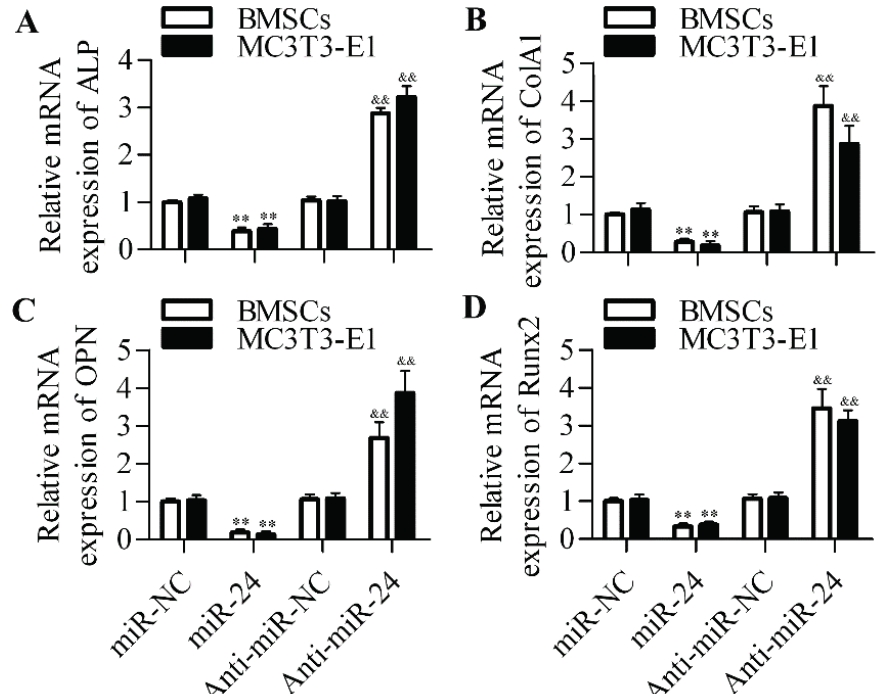
Figure 3. Effect of miR-24 gain or loss on the mRNA expression of osteogenesis-related genes. RT-qPCR was performed to detect the mRNA expression level of ALP ( A ), ColA1 ( B ), OPN ( C ) and Runx2 ( D ) in BMSCs and MC3T3-E1cells. Cells transfected with miR-24 or anti-miR-24 (day 0) for 48 h and then cultured in differentiation medium for induction of osteogenic differentiation. Cells were harvested at day 7 for analysis. N = 3, ** p < 0.01 vs. miR-NC; and && p < 0.01 vs.